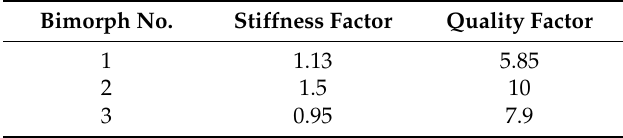
Table 1. Three bimorphs system without spring connections-stiffness and Q factors. Bimorph